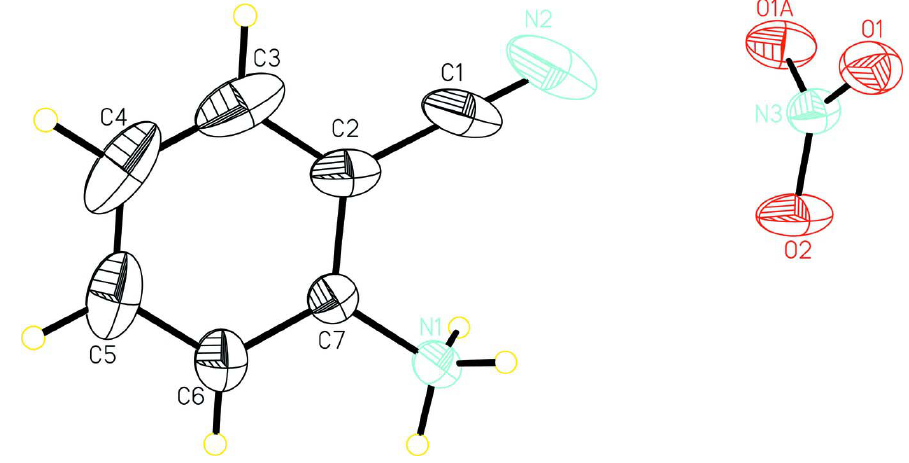
A view of the title compound with the atomic numbering scheme. Displacement ellipsoids are drawn at the 30% probability